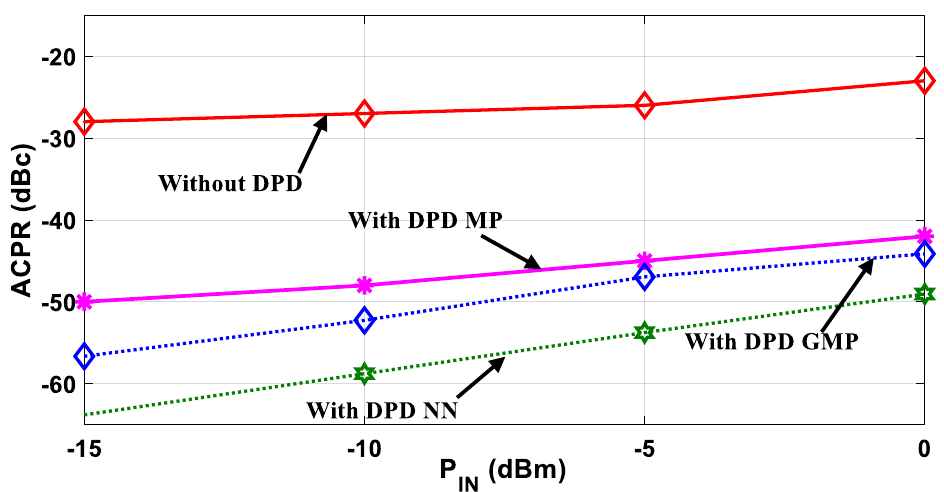
Figure 8. Experimental results for Adjacent Channel Power Ration (ACPR) results versus radio